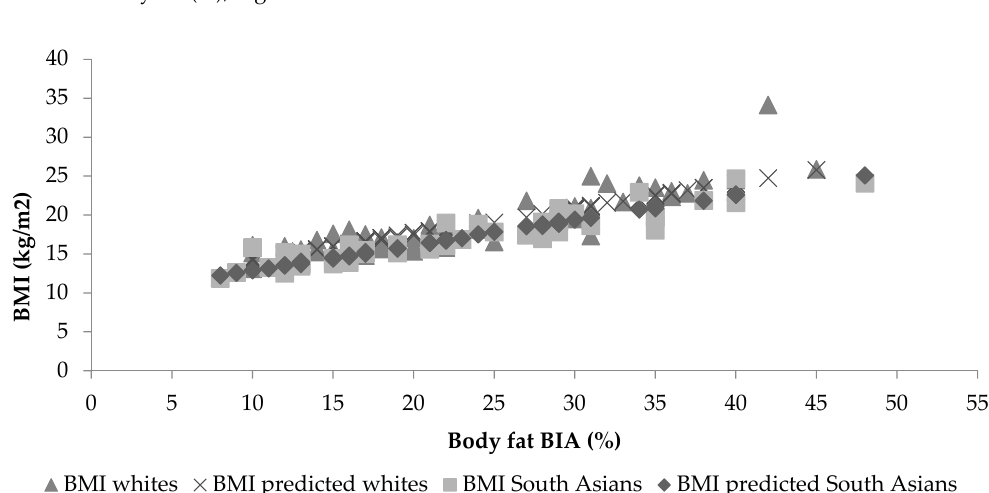
Figure 1. The association between body mass index (BMI) and bioelectrical impedance analysis (BIA) estimated body fat (%), together with the fitted lines for white and South Asian males.